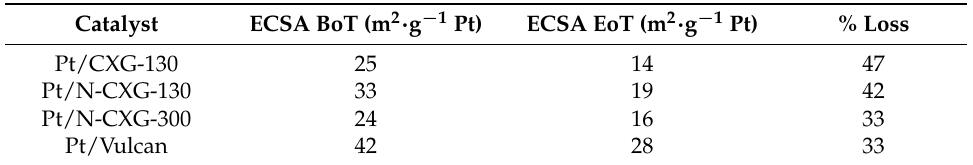
Table 6. Electrochemical surface area (ECSA) at the beginning and at the end of the accelerated degradation tests, calculated from cyclic